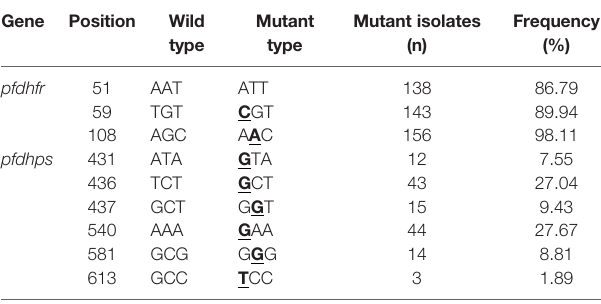
TABLE 1 | Prevalenceof pfdhfr and pfdhps polymorphismsinimportedAfricanisolates.